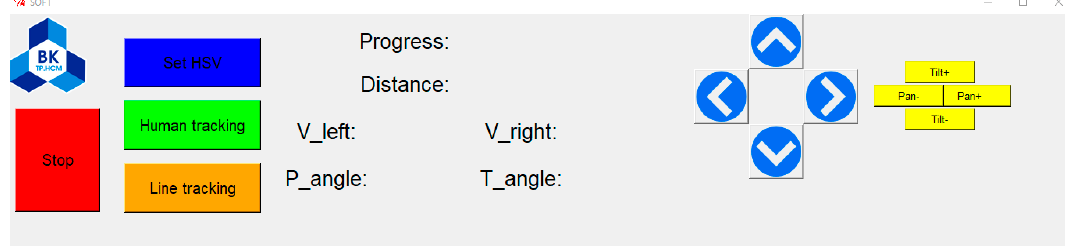
Figure 17. Structure of proposed fuzzy controller. In Figure 18; Figure 19, most of membership functions are triangular shape and trapezoidal shape because students were familiar with them. In fact, following the instructor’s guide, undergraduate learners were able to complete programming in a short amount of time. The sampling time set up in the micro-controller was 500 μ s to guarantee the real-time performance. To deal with the short cycle period, the fast computation consisting of singleton outputs was more relevant. ( a ) ( b ) Figure 18. Input membership functions: ( a ) load, and ( b ) tracking error.